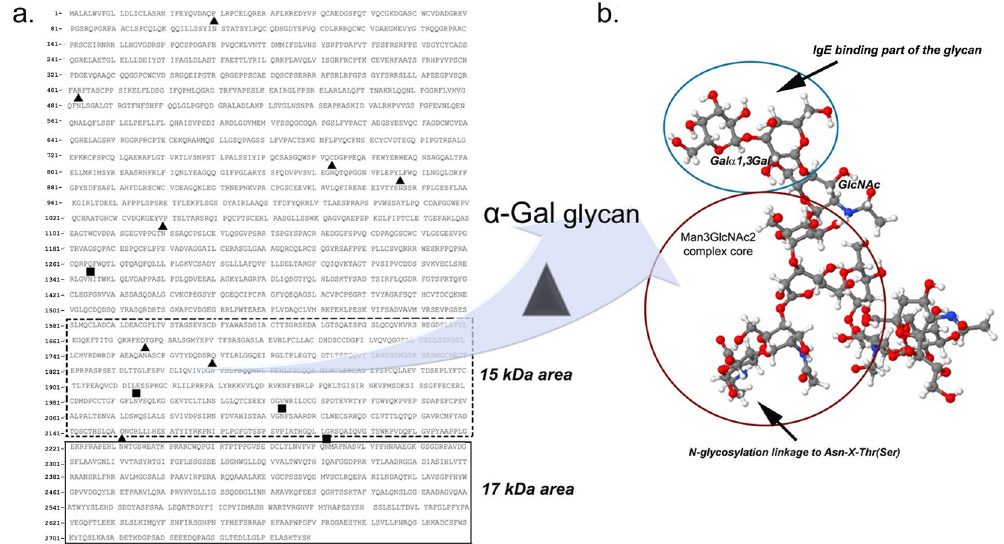
Figure 5. Peptidomics of α -Gal IgE-reactive peptides. ( a ) IgE reactive gastric peptides were identified using peptidomics and their corresponding regions in the bovine thyroglobulin sequence were identified (uniprot.org accession number P1027). Gastric peptides of 15–20 kDa, dark box; gastric peptides of 10–15 kDa, dashed box. Dark triangles above the sequence represent N-glycosylation sites with complex type of glycans; Dark squares above the sequence represent N-glycosylation sites with high mannose type of glycan. ( b ) Model of α -Gal glycan carried on peptide or protein. The IgE binding part of the glycan, the Gal- α 1,3-Gal epitope, is marked in the blue circle; The complex Man 3 GlcNAc 2 core of the glycan, where the end of the core is attached to protein/ peptide with N-glycosylation linkage to Asn-X-Thr(Ser) sequence (black arrow), is marked in the red circle. Model was created using Avogadro software